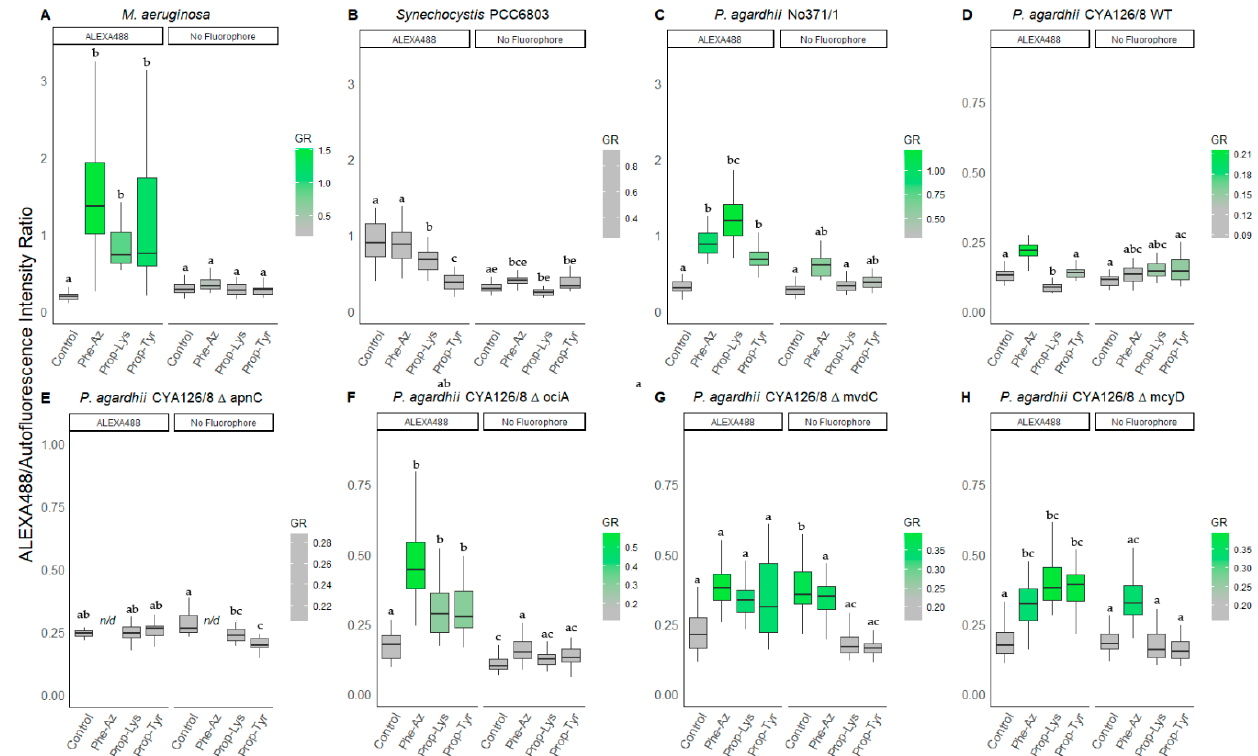
Figure 3. The ratio of green fluorescence intensity (ALEXA488) to red intensity (AF) for individual cells or filaments from ( A ) M. aeruginosa , ( B ) Synechocystis PCC6803, and ( C ) P. agardhii strain No371/1, ( D ) CYA126/8 WT, and ( E – H ) CYA126/8 gene knock out mutants: ( E ) ΔapnC (inactivated AP synthesis), ( F ) ΔociA (inactivated cyanopeptolin synthesis), ( G ) ΔmvdC (inactivated microviridin synthesis), and ( H ) ΔmcyD (inactivated